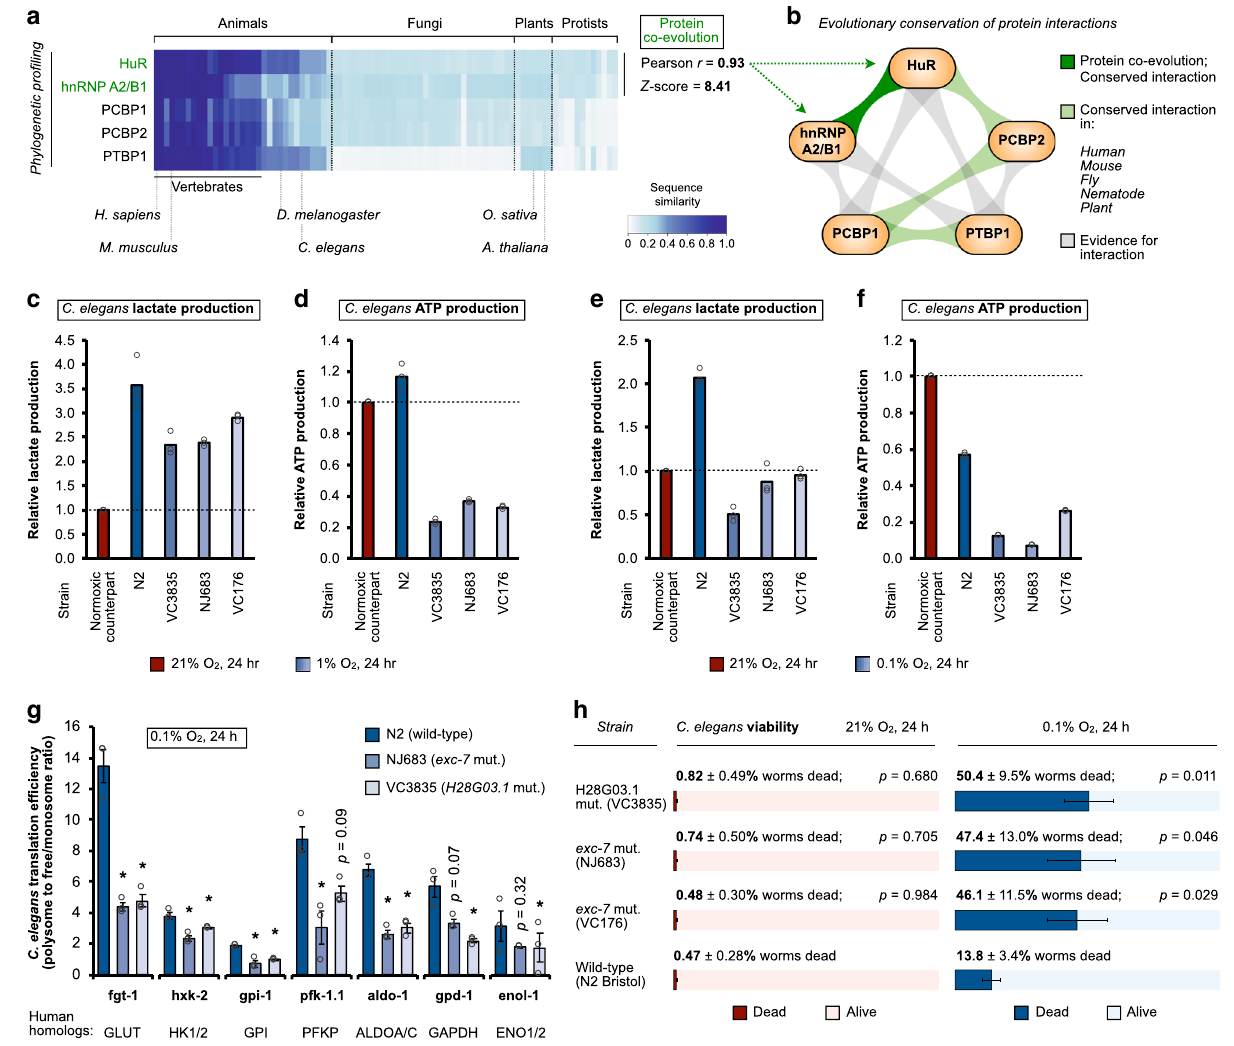
Fig. 6 The oxygen-sensitive RBP network regulates hypoxia sensitivity across species. a Protein sequence similarity of hypoxia-activated RBPs across species. High protein sequence similarity (compared to the human homolog, fi rst column) is indicated by dark blue coloring, and low protein similarity by light blue/white coloring (see legend on bottom right corner of panel). Analysis using the normalized phylogenetic pro fi ling algorithm identi fi ed evidence suggesting co-evolution between HuR and hnRNP A2/B1 (Pearson r = 0.93, z score = 8.41). b Analysis of published RBP interactome data using the BioGRID bioinformatics resource reveals conserved protein interactions (indicated in green) between hypoxia-adaptive RBPs. An interaction is considered conserved if observed in human, mouse, fl y, nematode, and at least one plant species. Measurements of c , e lactate and d , f ATP production in C.